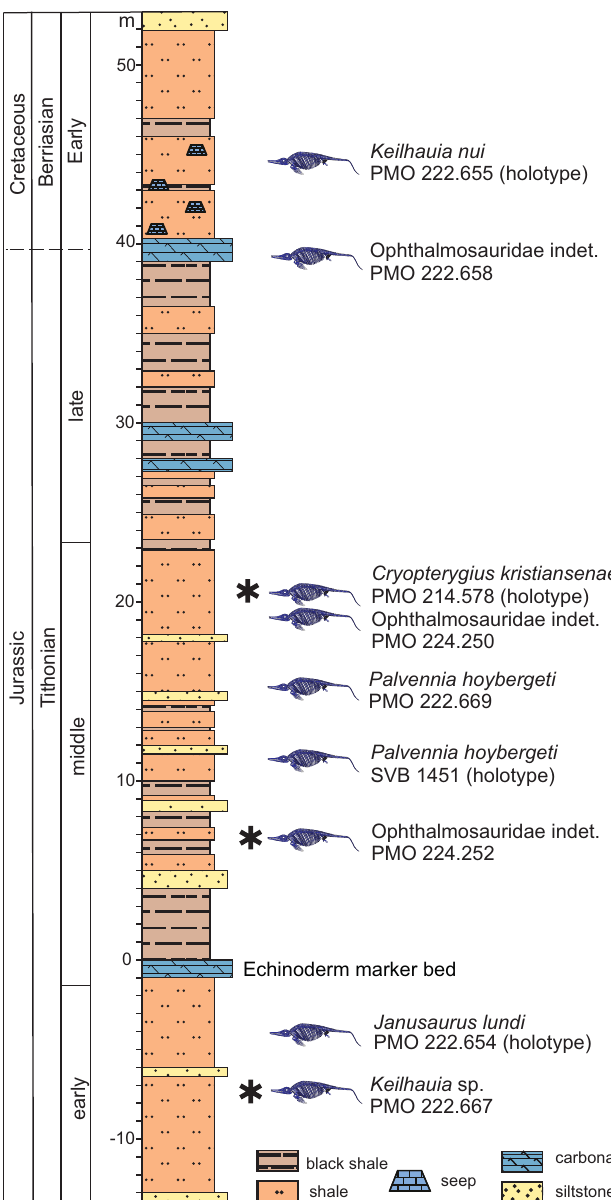
Fig. 2. Composite section of the Slottsmøya Member Lagerstätte with the ophthalmosaurids described and discussed in the text. Specimens described in this paper marked with an asterisk. Modified from Delsett et al. (2017). A bed with a high abundance of echinoderm fossils is set as marker bed (0 m) in the section (Hurum et al. 2012; Rousseau and Nakrem